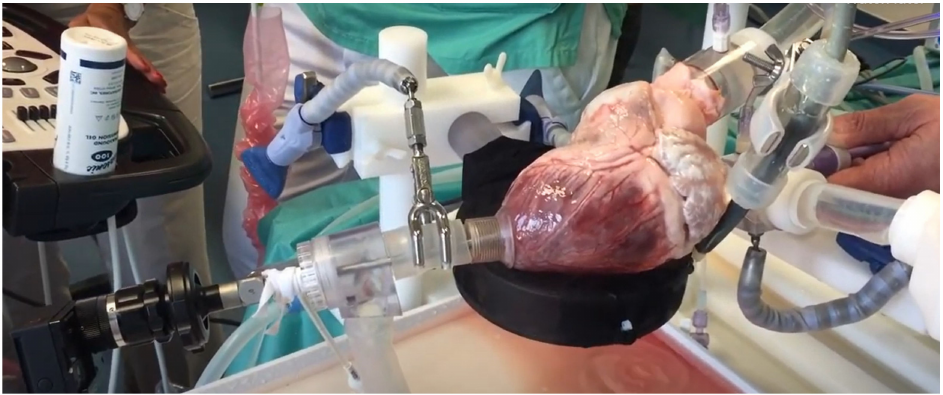
Figure 14. Porcine heart cardiac catheterization simulator